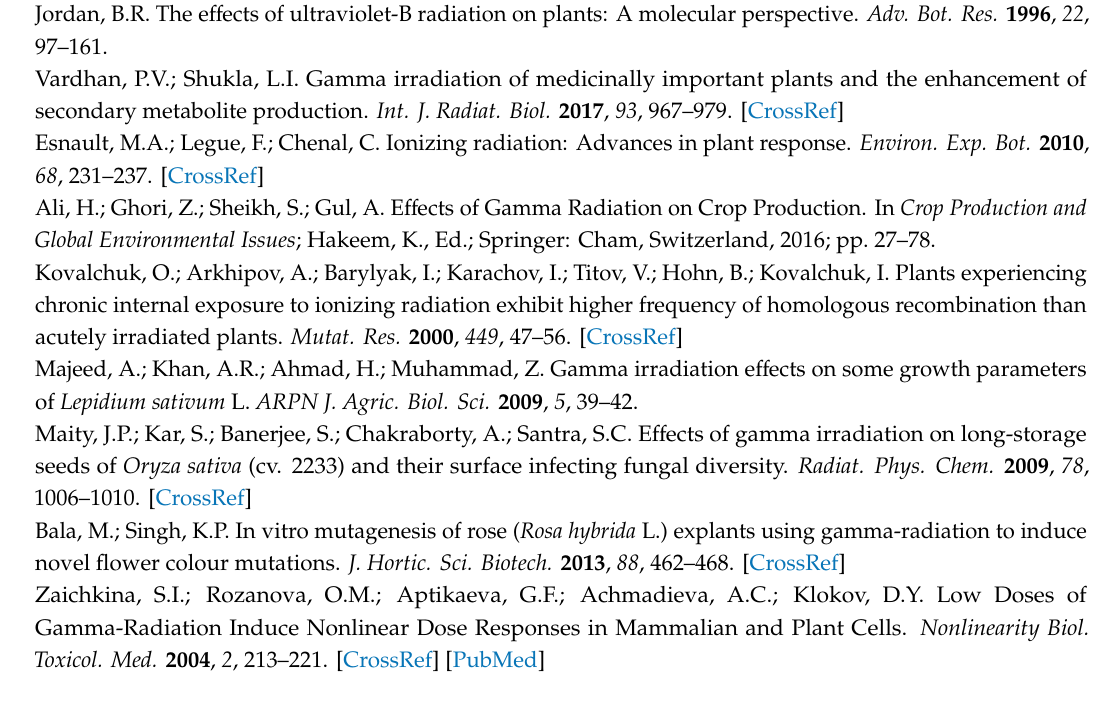
Table S1: List of primers designed and used in this